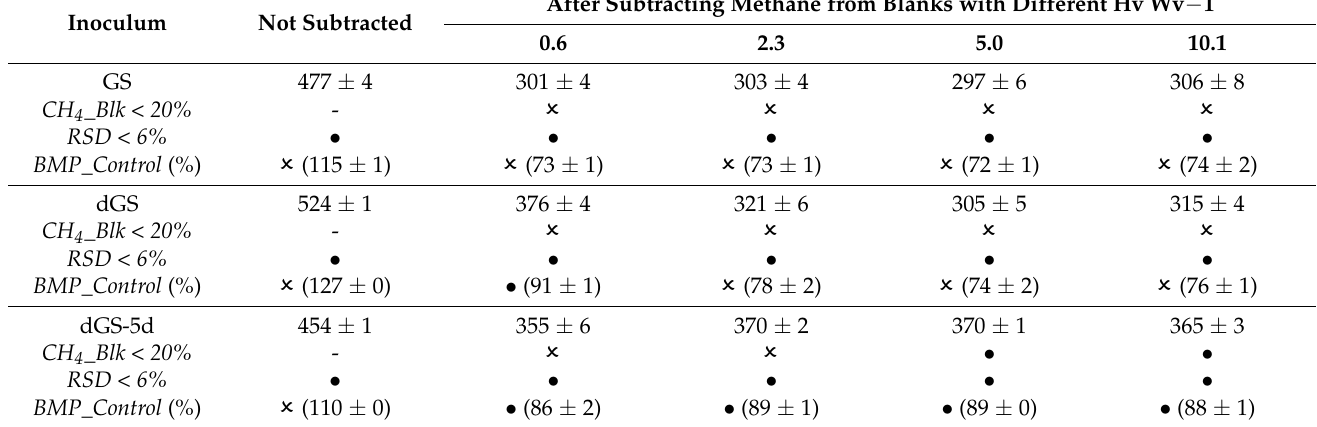
Table 2. BMP values (L ∙ kg − 1 ) of crystalline cellulose using digested sewage sludge (DSS) or degassed DSS (dDSS) as inocula, before and after subtracting the methane produced in the different blanks (Hv ∙ Wv − 1 of 0.6, 2.3, 5.0 and 10.1). The corresponding % of the theoretical BMP max is shown between brackets in BMP_Control (%). The ful fi llment ( ● ) or not (  ) of the proposed validation